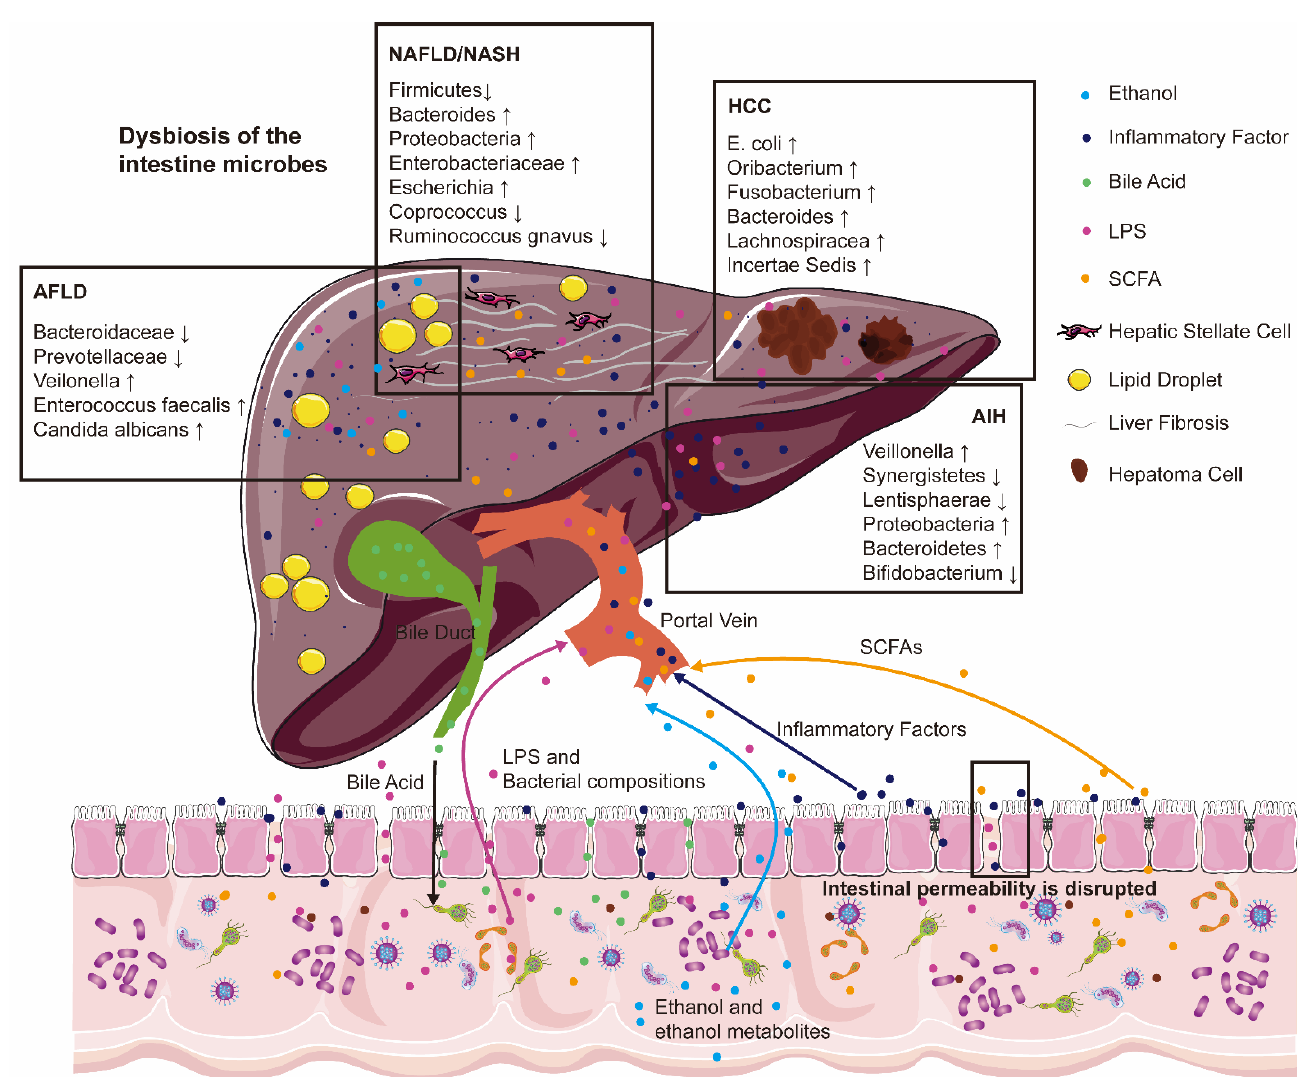
Figure 1. Intestinal microbial dysbiosis and increased intestinal permeability are associated with the pathogenesis of many chronic liver diseases. Bacterial compositions (lipopolysaccharides (LPS)), intestinal bacterial metabolites (ethanol and ethanol metabolites, short-chain fatty acids (SCFAs)), and inflammatory factors are deeply involved in alcoholic fatty liver disease (AFLD), non-alcoholic fatty liver disease (NAFLD), non-alcoholic steatohepatitis (NASH), autoimmune liver disease (AIH) and the development of hepatocellular carcinoma (HCC). Arrows with different colors represent the flow direction of different metabolites between liver and intestine. “ ↑ ” represents the increased abundance of the corresponding bacteria. “ ↓ ” represents the decreased abundance of the corresponding bacteria.